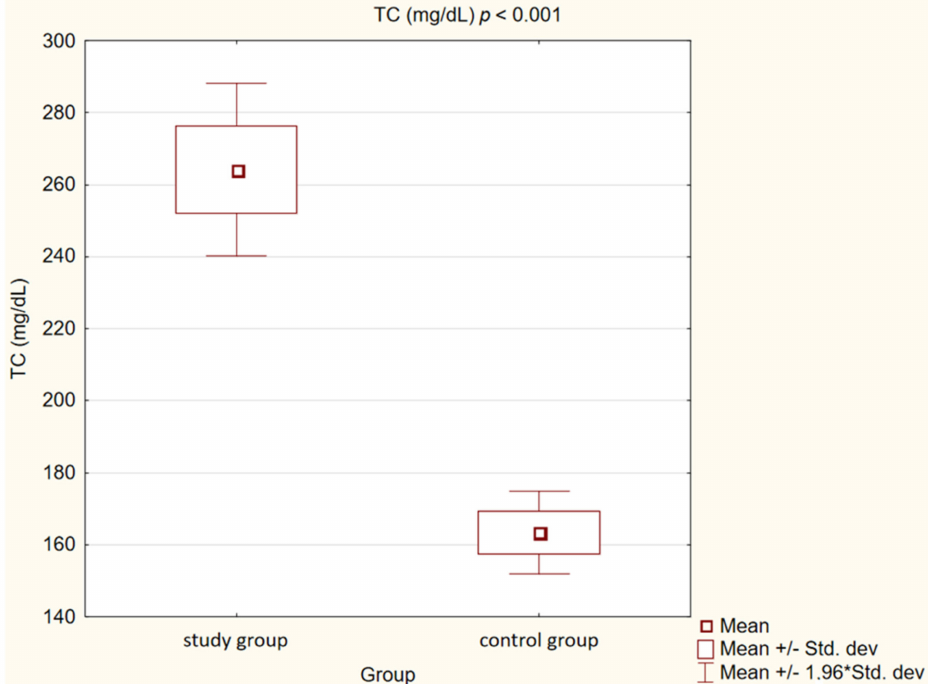
Figure 1. Concentration of total cholesterol (TC) in study and control group.